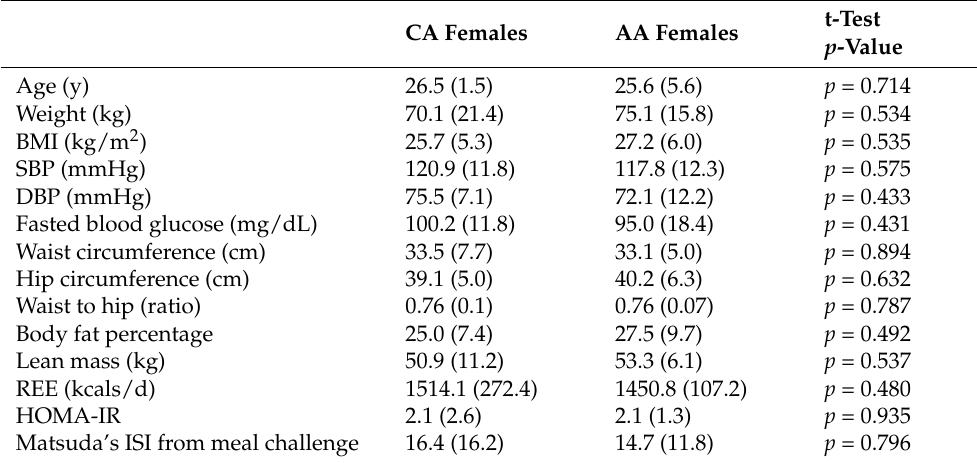
Table 1. Subject characteristics and insulin sensitivity